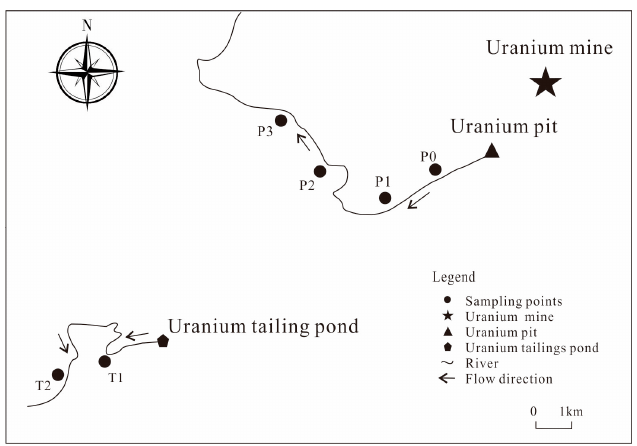
Figure 1. Sampling diagram of a uranium mining area in northern Guangdong. Table 1. Basic parameters of the soil samples.